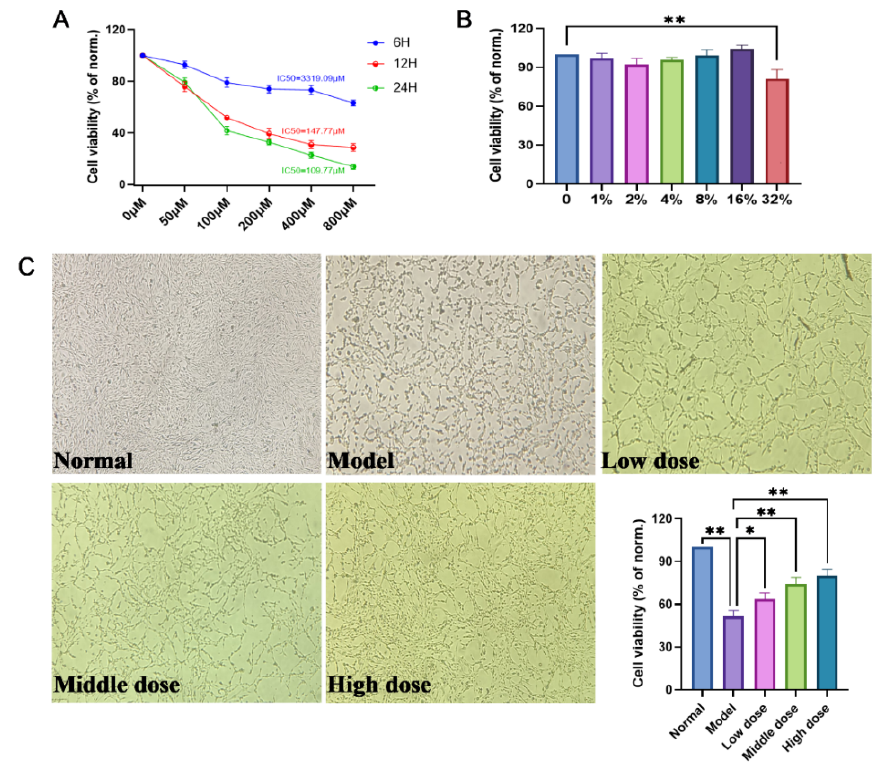
Figure 8. Protective effects of SMP on H 2 O 2 -induced PC12 cells. ( A ) Effects of various concentrations and treatment times of H 2 O 2 on the viability of PC12 cells; ( B ) Effects of SMP on the viability of normal PC12 cells; ( C ) Effects of SMP (4%, 8%, and 16%) on the viability of H 2 O 2 -induced PC12 cells. SMP: Salvia miltiorrhiza-containing plasma. For data expressed as mean ± SD ( n = 3), * p < 0.05 and ** p < 0.01 vs. model group.